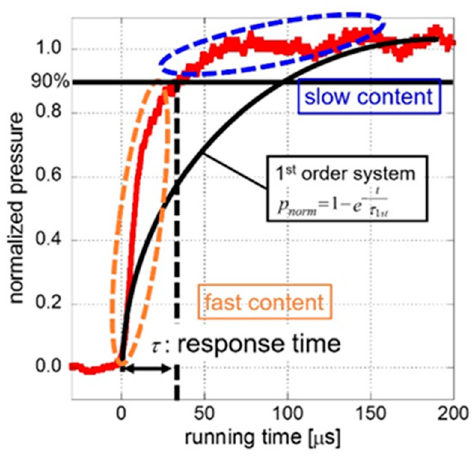
Figure 10. Representative step response of the PC-PSP sample at reference temperature condition.